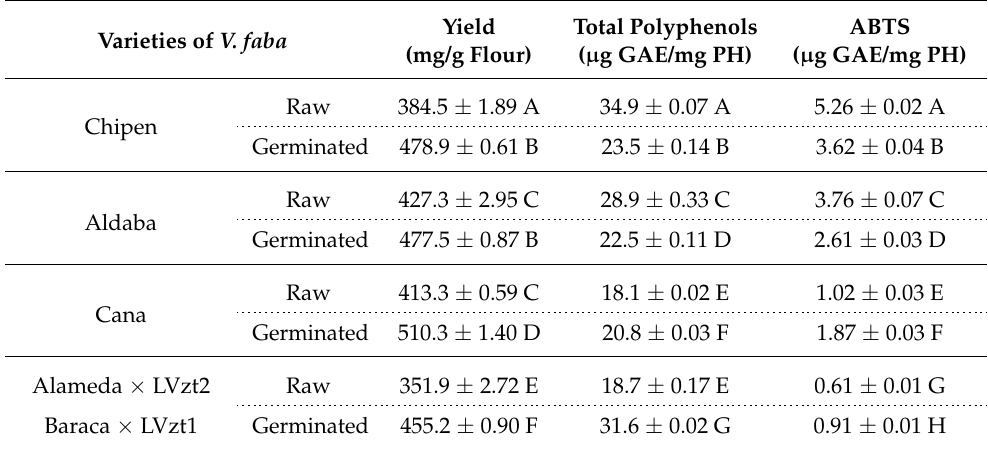
Table 2. Quantification of the total polyphenols and antioxidant capacity in different V. faba varieties (raw and germinated